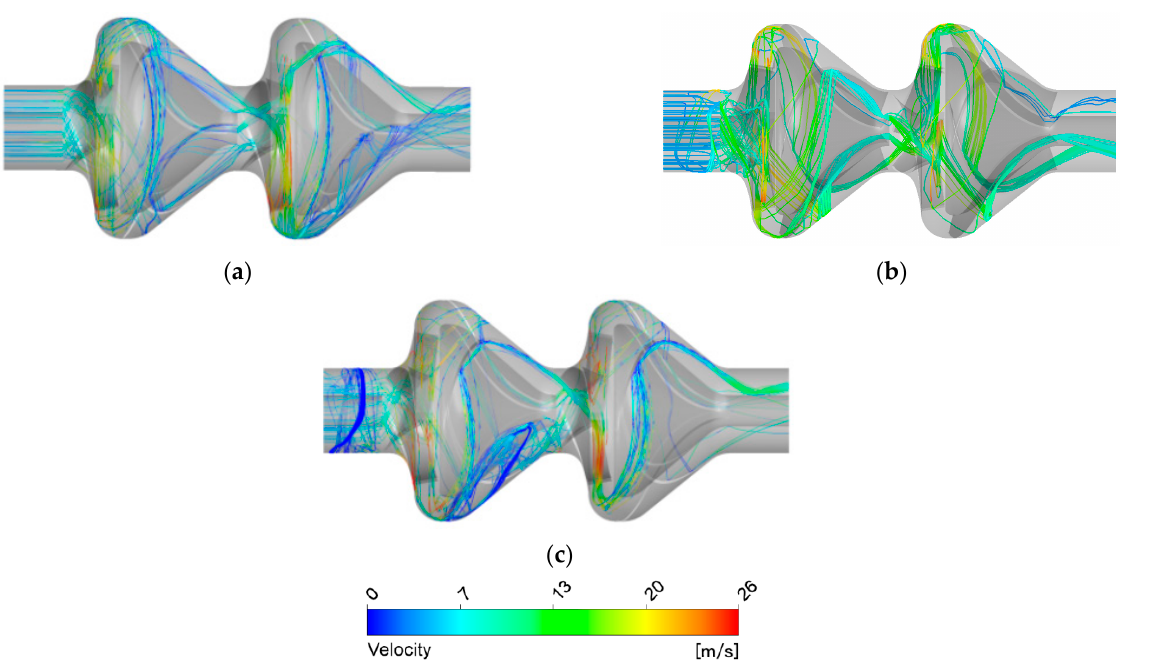
Figure 21. Particle movement trajectories in the calculation domain: ( a ) n = 900 r/min; ( b ) n = 1450 r/min; ( c ) n = 1800 r/min.